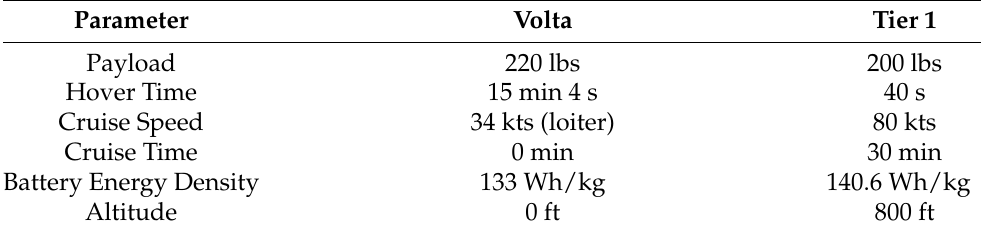
Table 2. Mission parameters used in the test